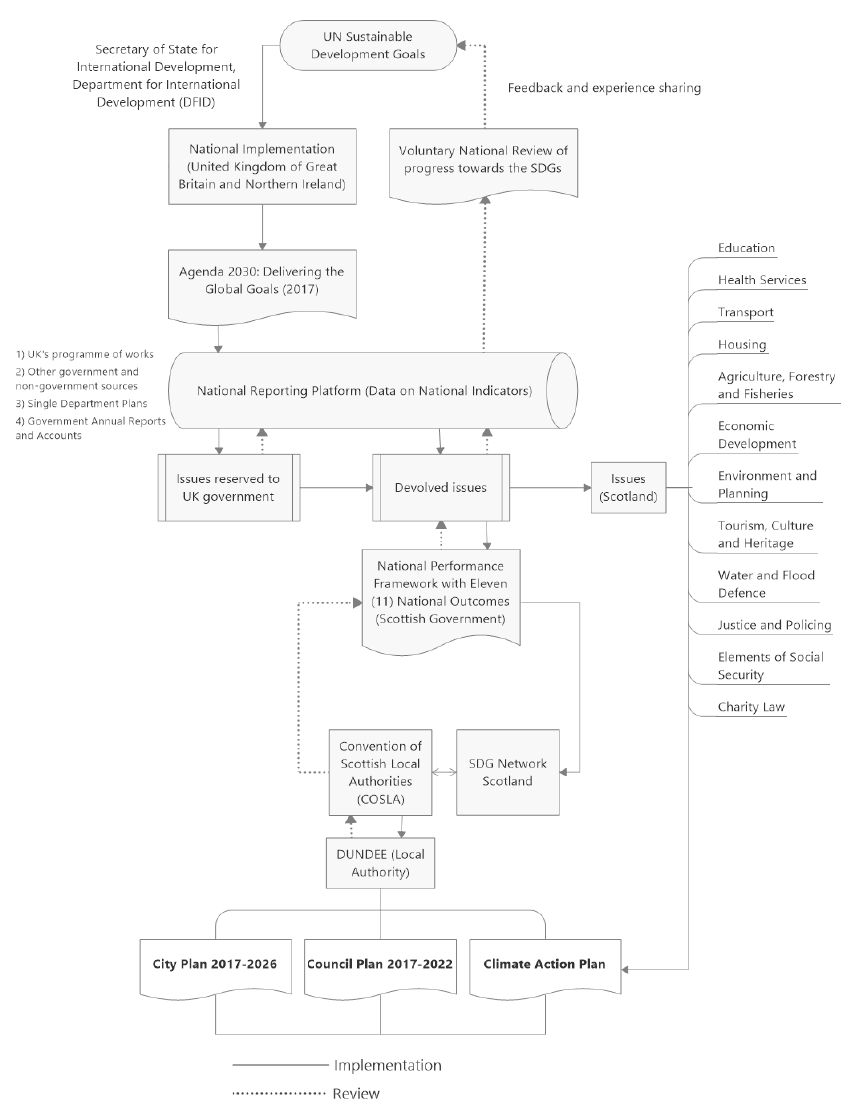
Figure 5. Model of SDG adoption (source: authors’ review of Dundee’s planning framework in the context of national planning arrangements).